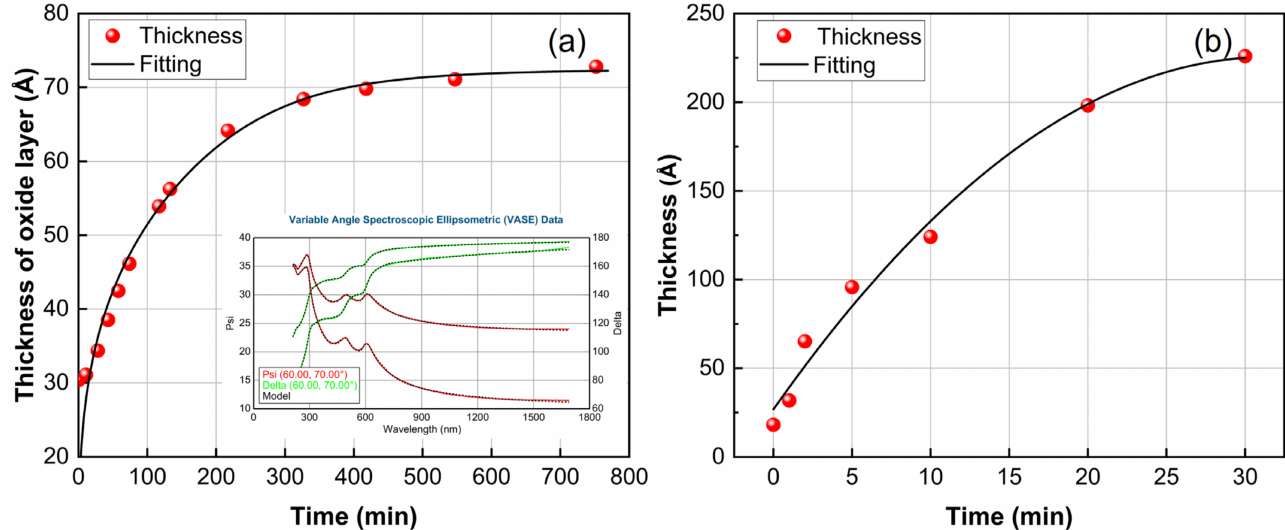
Figure 2. Oxidation trend in substrate surface under different oxidation environments. ( a ) The trend in the oxide layer thickness of the substrate surface in the atmosphere with time; ( b ) the trend in oxide layer thickness on the substrate surface in deionized water with